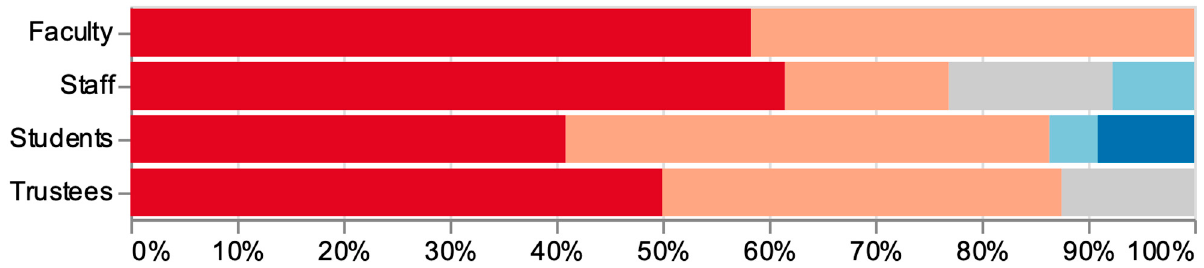
Figure 5. “Bivocational ministry is a lesser commitment to one’s call compared to fully-funded ministry.” (Q5). 51% strongly disagree; 36% disagree; 5% neutral; 4% agree; 4% strongly agree.